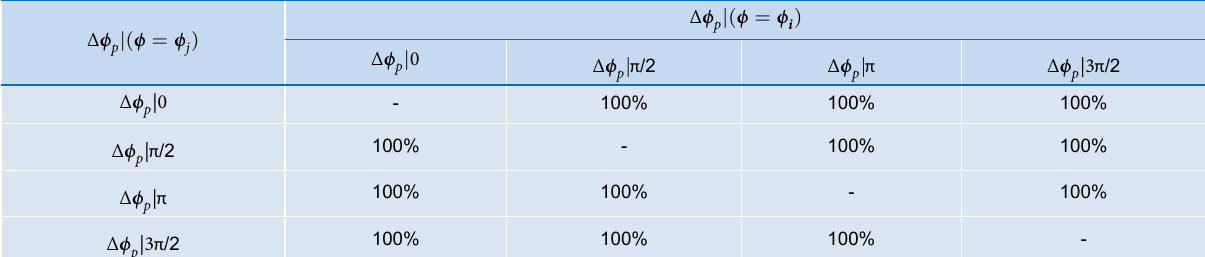
S ϕ = ϕj Table 2 | Probability that any two sets and have the same symbol under encoding rule (0, π/2, π, 3π/2).